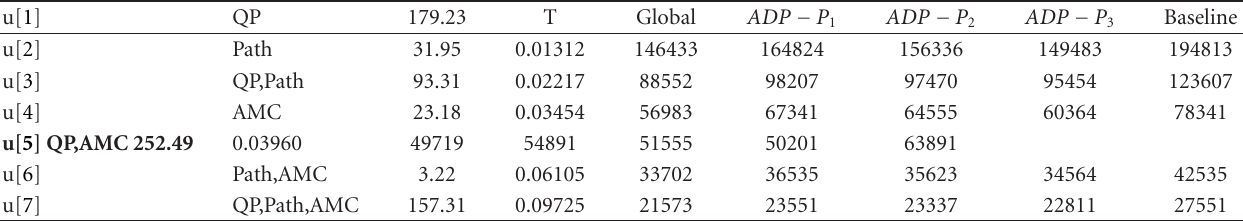
Table 1: Perceptual video quality comparison based on H.264 codec in a real-time environment T frame = 35 ms ), where (a) globally optimal, (b) near optimal, and (c) the best